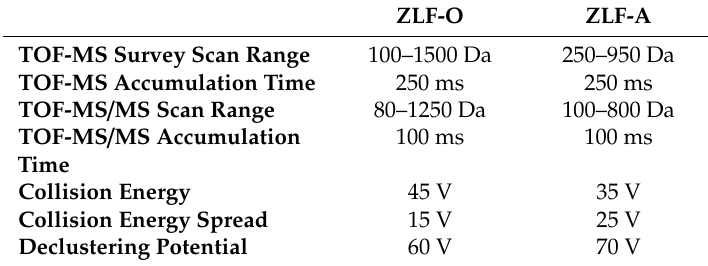
Table 3. Information dependent acquisition (IDA) parameters applied in HR MS / MS